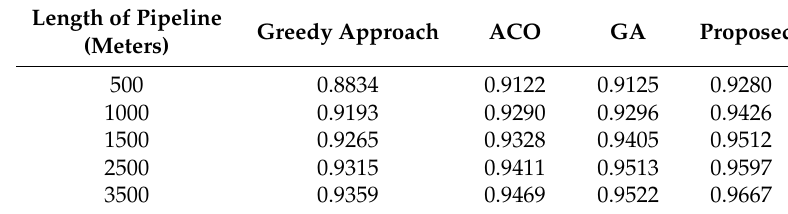
Table 9. Comparison of Normalized Life Time (Range 50 m).